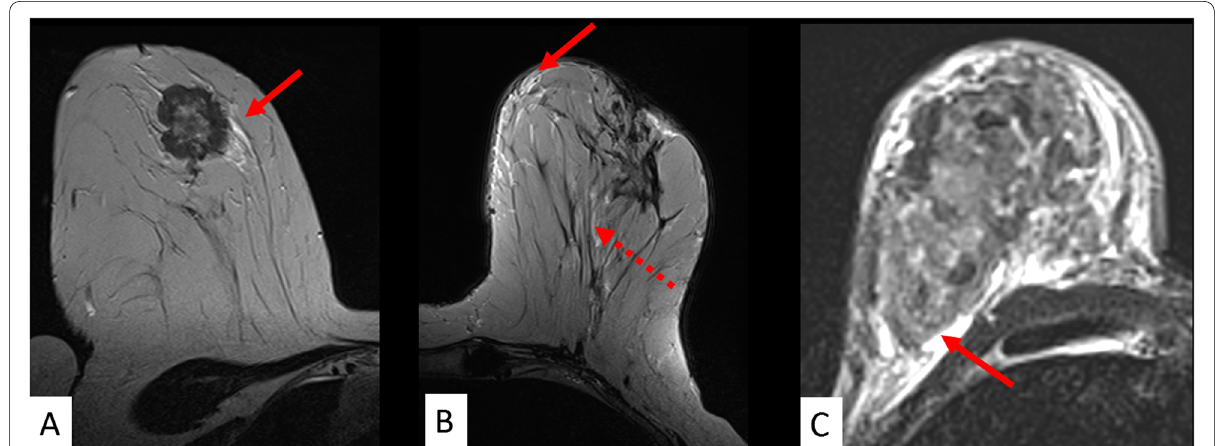
Fig. 5 The pivotal role of T2‑weighed images: oedema. Any asymmetric ipsilateral T2‑weighted signal increase not due to the tumour itself, cysts or artefacts is referred to as “oedema” in A , B , and C . Different oedema patterns are distinguished such as perifocal ( A ), full red arrow), subcutaneous ( B , full red arrow), prepectoral ( C , full red arrow), and diffuse ( B , dotted red arrow). Oedema is considered among the best evaluated predictive/ prognostic criteria and was associated with high grade and nodal‑positive cancers as well as disease recurrence (see also Table 1)